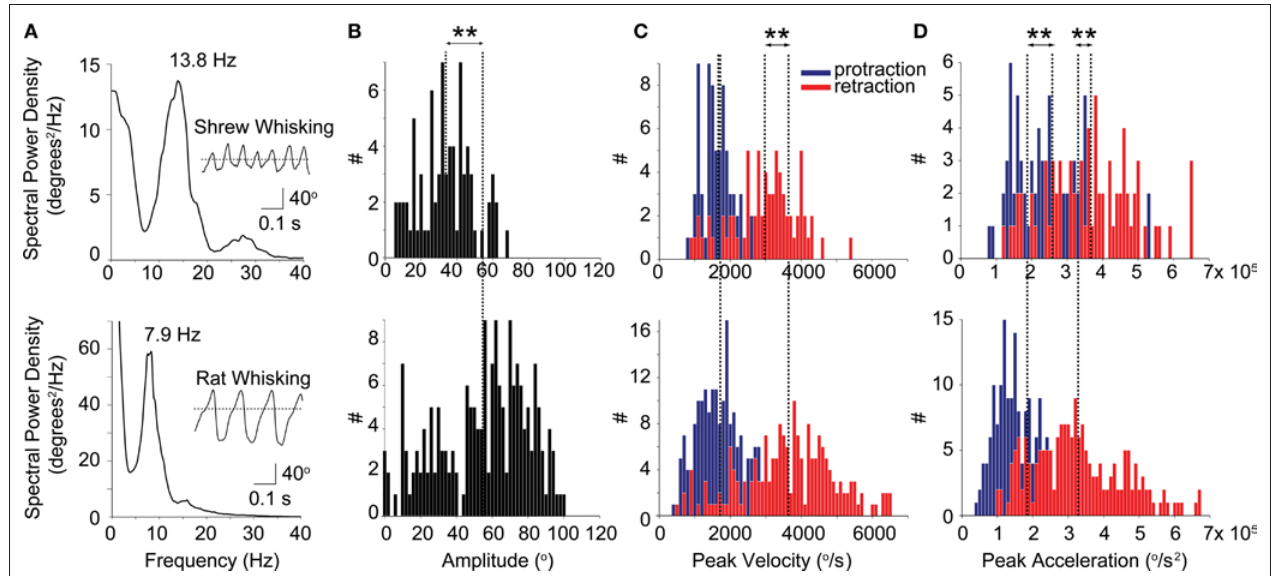
rats retracted their whiskers (red bars) with higher velocity than shrews (3.638 ± 1.301 × 10 3 ° /s versus 2.972 × 0.941 × 10 3 ° /s, respectively, p < 0.01). Both shrews and rats retracted their whiskers much faster than they were protracted. (D) Both protraction and retraction acceleration were higher in shrews than rats (protraction: 2.581 ± 1.107 × 10 5 ° /s 2 versus 1.844 ± 0.985 × 10 5 ° /s 2 , respectively, p < 0.01, retraction: 3.665 ± 1.264 × 10 5 ° /s 2 versus 3.276 ± 1.273 × 10 5 ° /s 2 , respectively, p < 0.01, two-tailed Welch’s t -test, all values are given as the mean ± 1